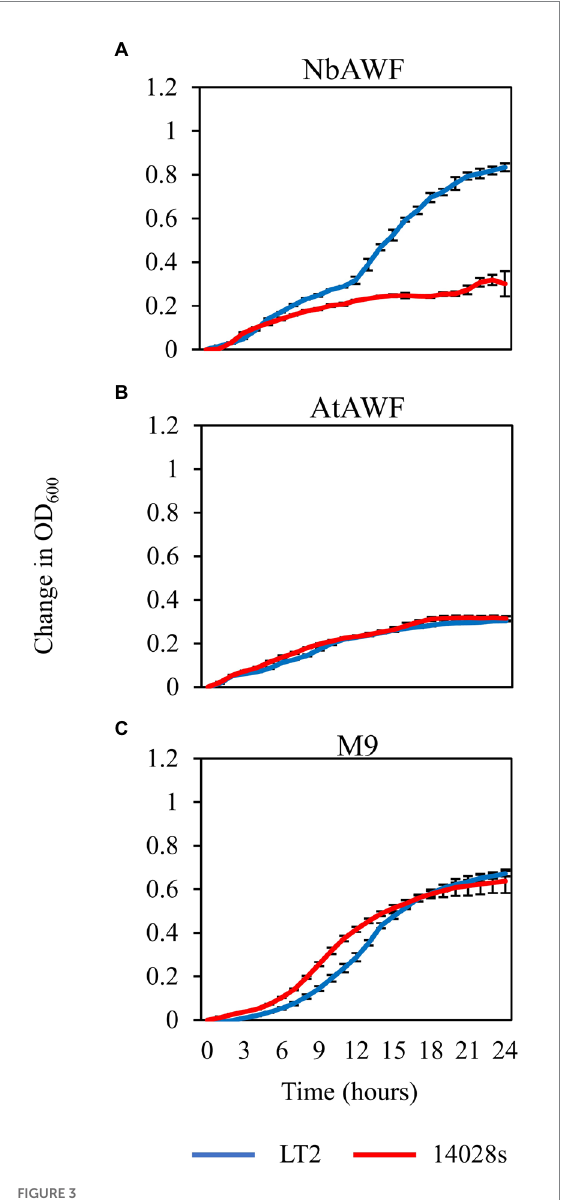
FIGURE 3 Salmonella enterica strain LT2 exhibits more rapid growth with a pronounced biphasic growth pattern in ex planta N. benthamiana apoplastic wash fluid. Growth curves of S. enterica LT2 (blue) and S. enterica 14028s (red) in (A) N. benthamiana apoplastic wash fluid (NbAWF), (B) A. thaliana apoplastic wash fluid (AtAWF), and (C) M9 minimal media. Cultures were incubated at 22 ° C, and the OD 600 was recorded every hour. Growth was measured as the mean change in OD 600 . Error bars show standard deviation ( n = 5 wells). Two independent experiments were conducted with similar